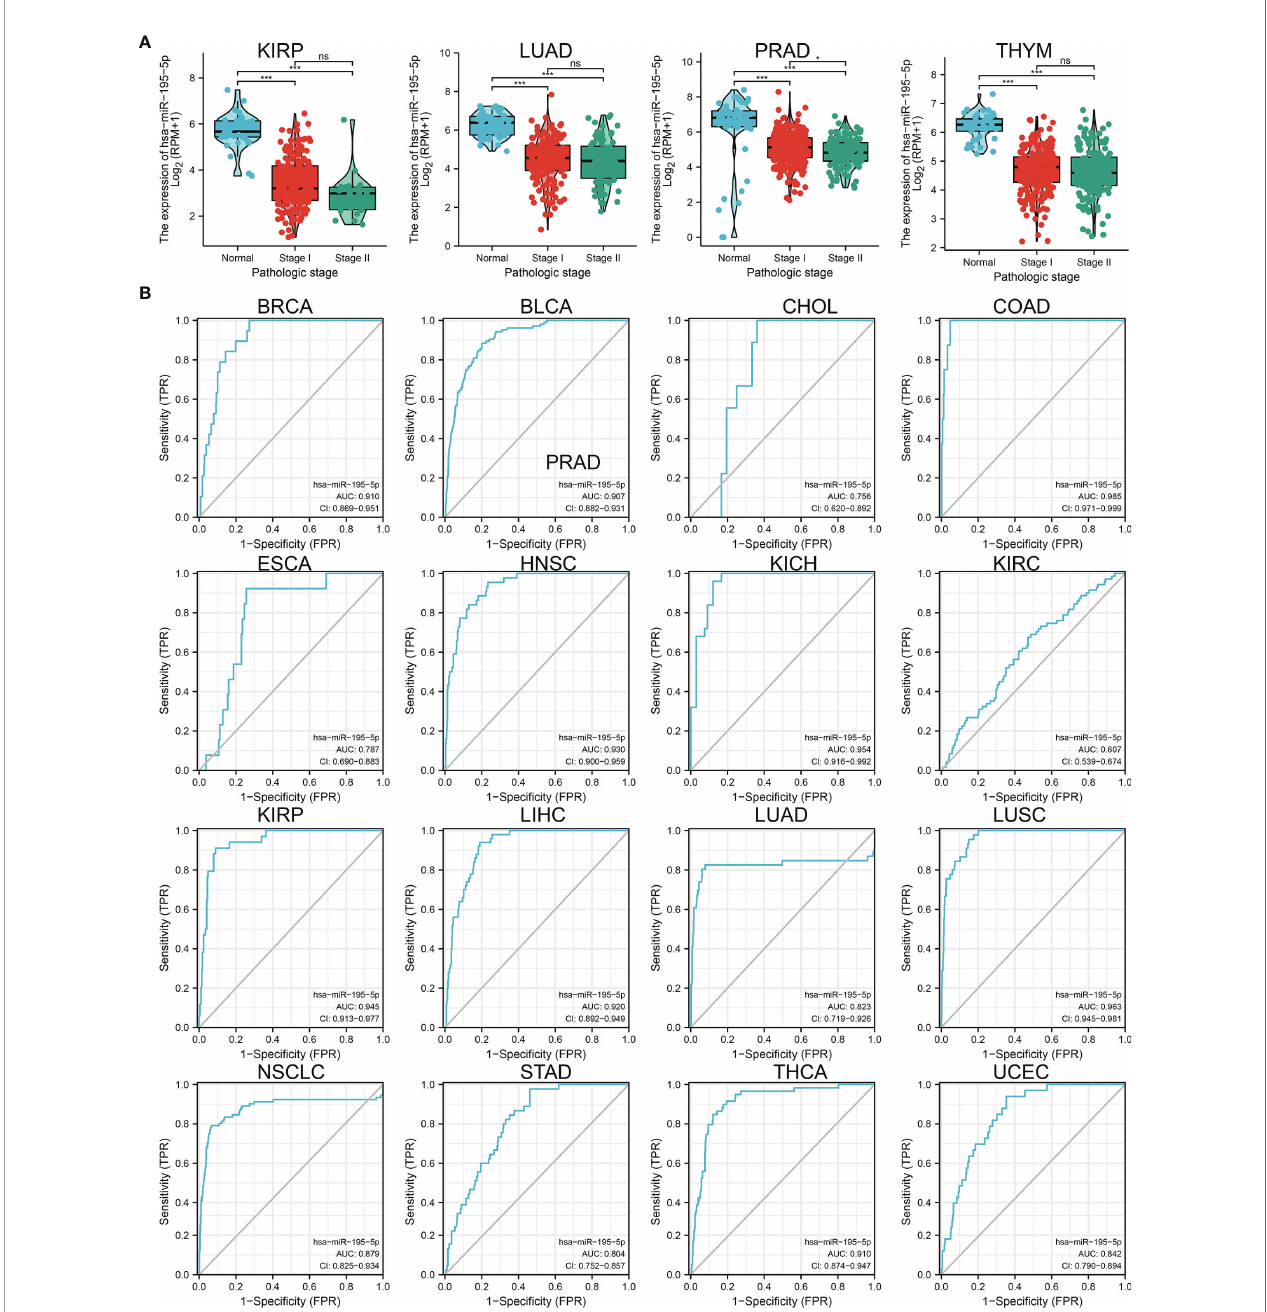
FIGURE 2 | Analysis of the tumor stage and ROC curve for miRNA-195-5p in human cancers. (A) The tumor stage for miRNA-195-5p in KIRP, LUAD, PRAD, and THYM. (B) ROC curve analyses and AUC values for miRNA-195-5p in diverse human cancer. *P<0.05; ***P<0.001; NS, p >